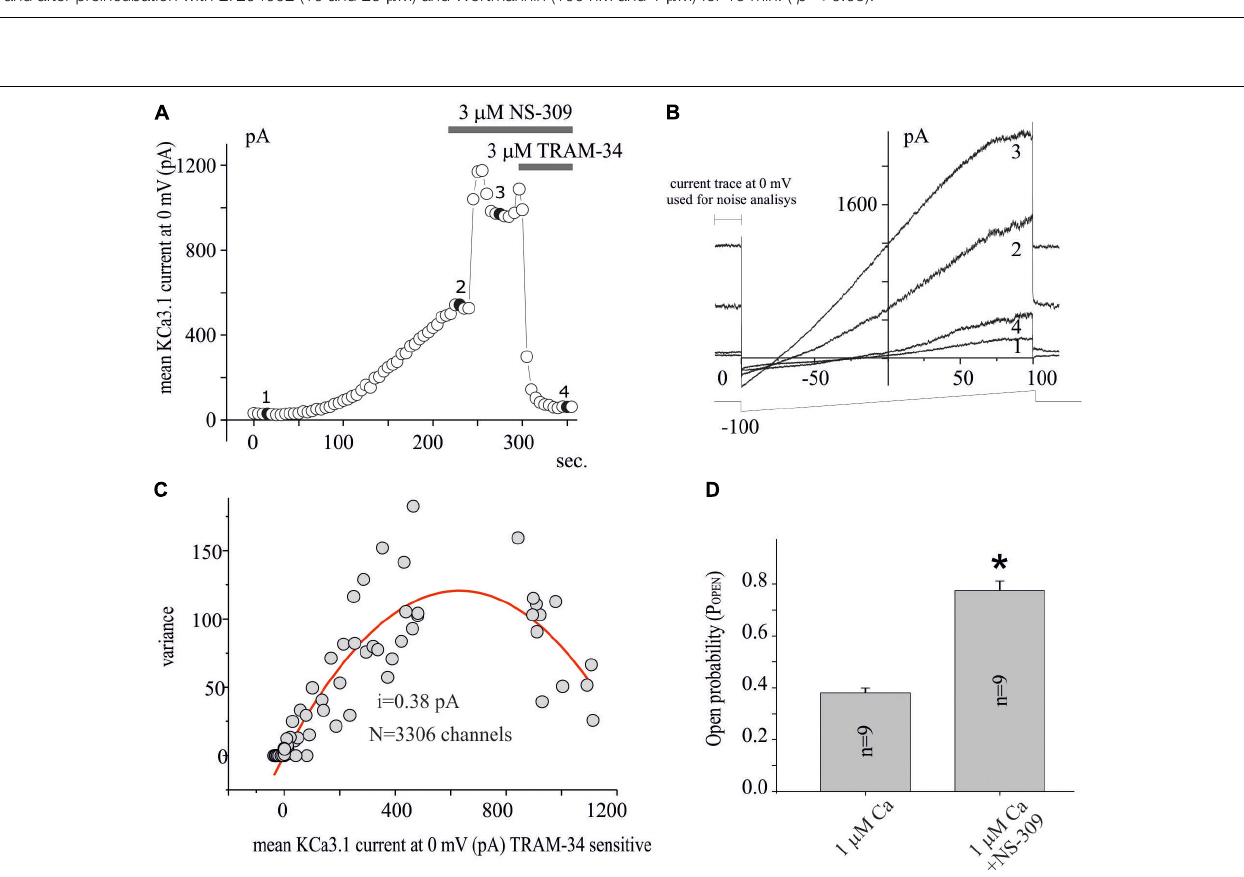
FIGURE 1 | The KCa3.1 current in the U251 GB is inhibited by LY294002 but not by Wortmannin. (A) Exemplified time course in CTRL condition of the current at 0 mV measured by the current ramps obtained by applying linear gradients of potential from –100 to 100 mV (Vh of 0 mV) repeated every 5 s. The time when TRAM-34 is applied is also reported during recording (blue bar). Inset (A) Current ramps recorded in the times indicated in panel (A) just break of seal (1, black), after KCa3.1 current stabilization (2, red), and after 3 µ M TRAM-34 block (3, green). (B) Bar plot of KCa3.1 current density normalized both in CTRL conditions (vehicle) and after preincubation with LY294002 (10 and 25 µ M) and Wortmannin (100 nM and 1 µ M) for 15 min. (* p < 0.05).